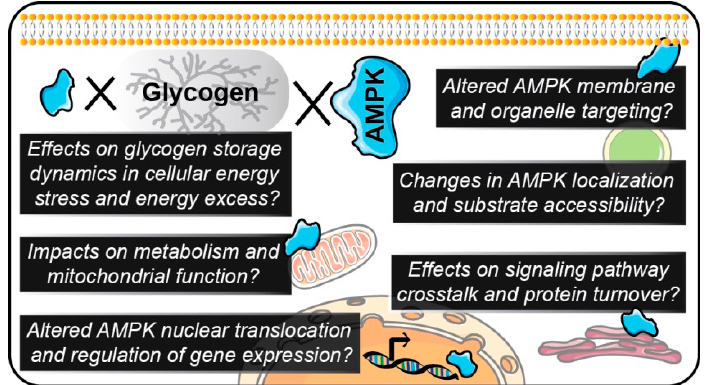
Figure 2. There are several potential alterations in cellular metabolism and signaling as a consequence of dysregulated AMPK-glycogen physical and functional interactions that represent key knowledge gaps in our current understanding and warrant further investigation in future studies. These potential alterations include changes in AMPK localization, translocation, substrates, and signaling pathway crosstalk, and subsequently, alterations in gene expression, cellular metabolism and glycogen storage.